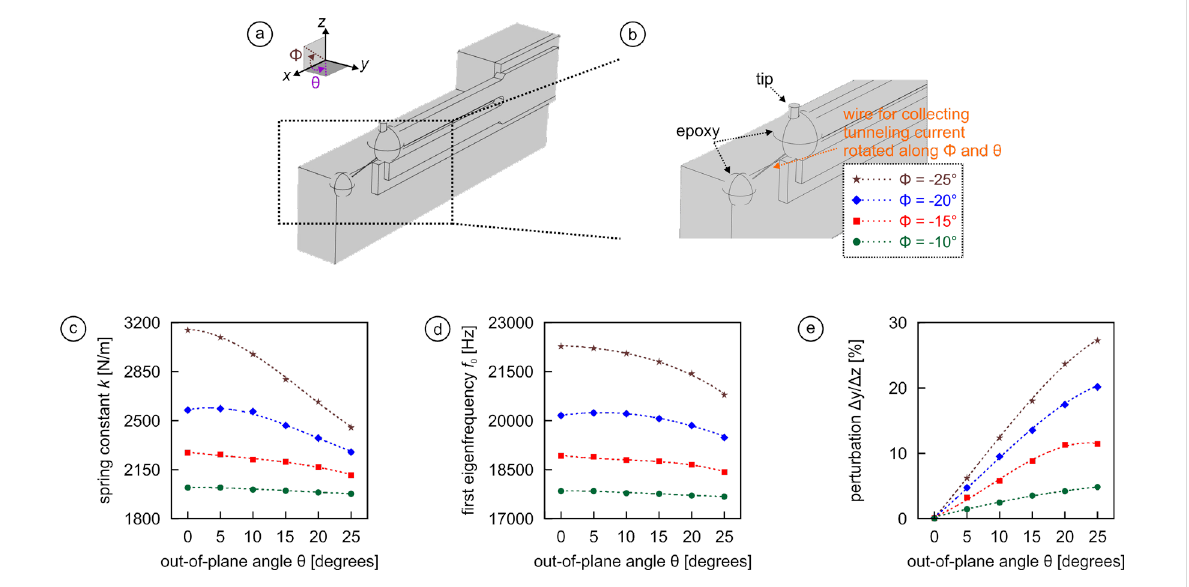
Figure 6: Effect of out-of-plane asymmetry ( x – y plane) of the wire used to collect the tunneling current on k , f 0 , and ∆ y / ∆ z . The use of a thin gold wire with 10 µm diameter is assumed, both the in-plane angle and the out-of-plane angle θ are defined in panels (a) and (b). Calculations for the out-of- plane angle θ run from 0 to 25°. For larger angles, the spherical 150 µm diameter epoxy blob securing the end of the wire to the holder would lose its contact with the holder. We show evolution of k (c), f 0 (d), ∆ y / ∆ z (e) for different in-plane angles and different sets of the out-of-plane angle θ